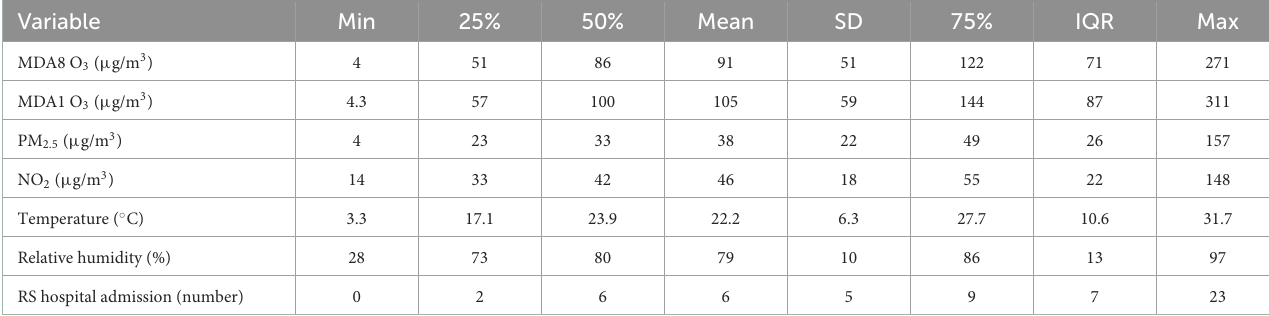
TABLE 1 Descriptive statistics of different O 3 indicators, meteorological factors and hospitalization for respiratory diseases in Guangzhou.